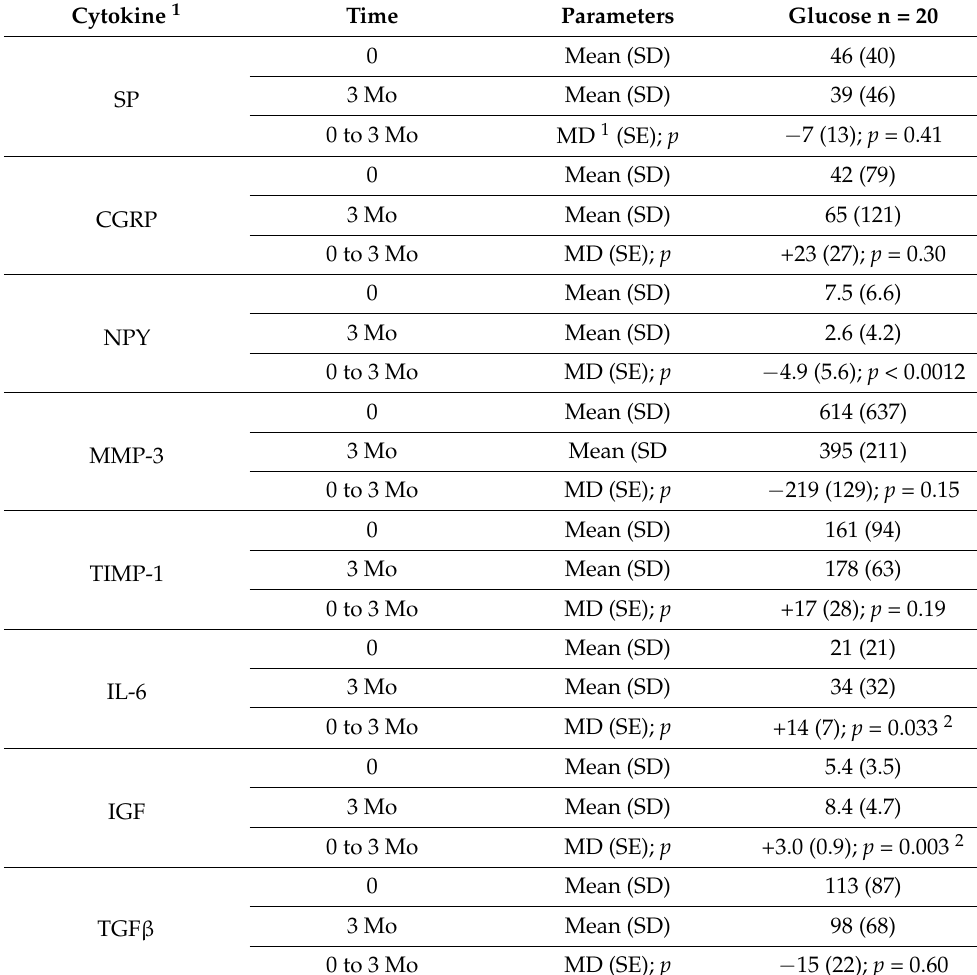
Table 4. Cytokine concentrations in picograms/mL, adjusted for total protein concentration, and within group p -value for change from 0 to 3